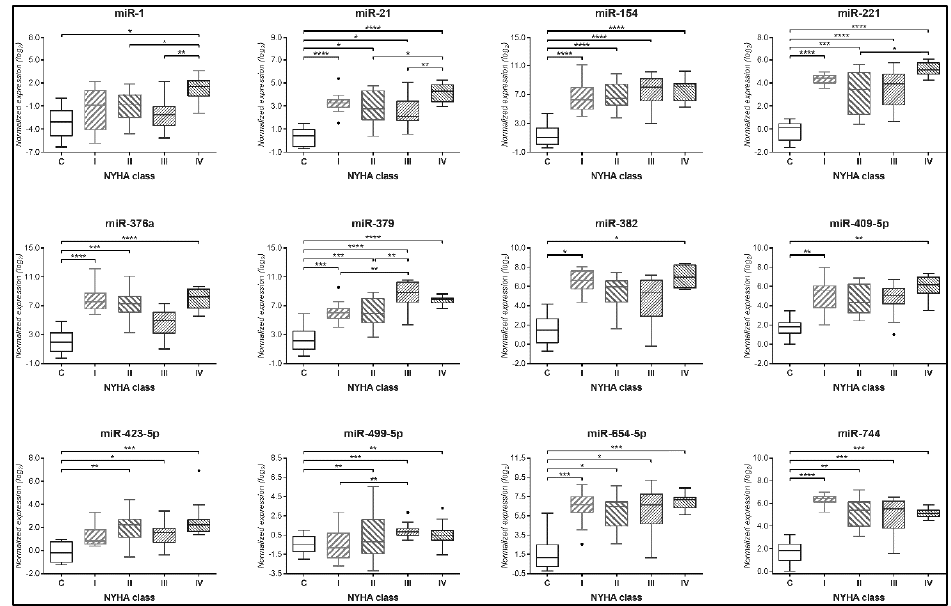
Figure 2. Plasma miRNAs regulated in Heart Failure. Twelve circulating miRNAs showed increased levels in patients belonging to NYHA class I to IV vs. healthy controls (C), even after adjustment for age, sex, personal history of diabetes mellitus, hypertension, and/or hypercholesterolemia, and smoking habit. These miRNAs were all significant at the analysis of covariance (ANCOVA) for p < 0.01. The expression of each miRNA is represented by box and whiskers plots. C n = 10, NYHA I n = 14, NYHA II n = 17, NYHA III n = 16, NYHA IV n = 14. * p < 0.05, ** p < 0.01, *** p < 0.001, **** p < 0.0001 at Tukey’s multiple comparison test.